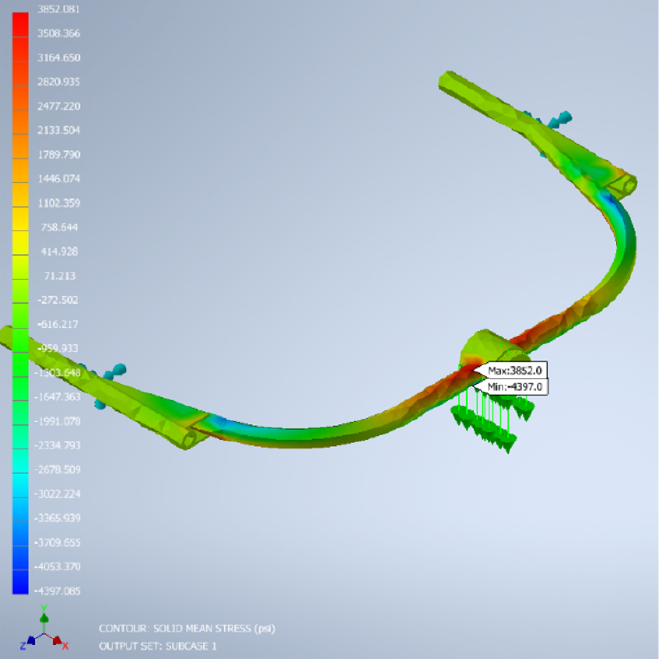
Figure 17. FEM Analysis of the mechanical parallel support part